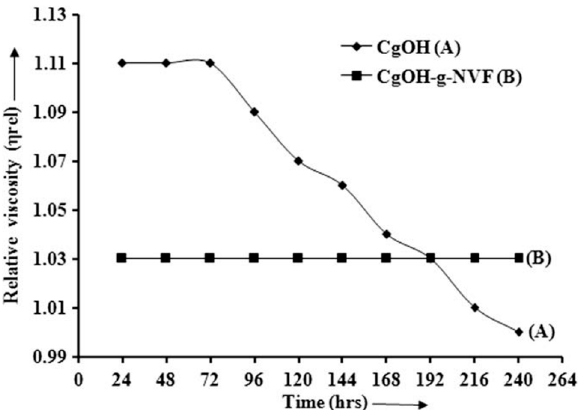
Figure 14. Resistance to the biodegradability of κ -carrageenan and its graft copolymer ( κ -carragenan- g - N -vinyl formamide), reprinted with permission from [93]. Copyright Elsevier, 2010.